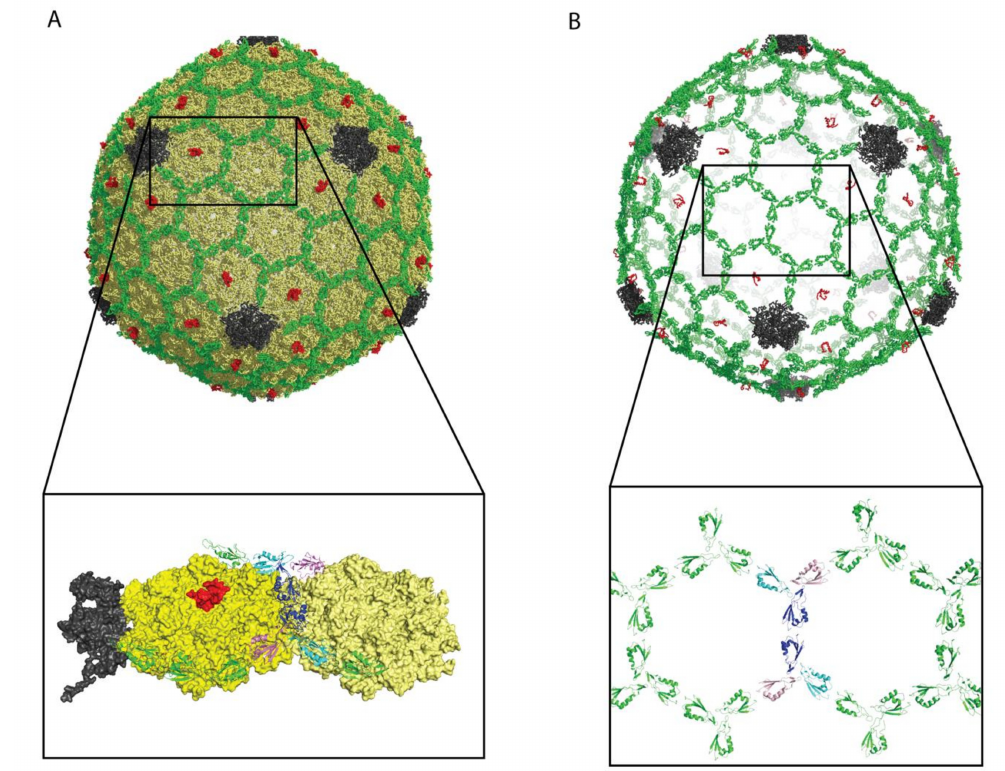
Figure 3. Structure of isometric T4 heads bound by Soc (T4) and Hoc (T4). The data are from PDB file 5VF3 [28]. ( A ) View of the complex: coat protein—yellow, vertex protein—grey, Soc (T4)—green, Hoc (T4)—red. Please note that only a small part of the HocT4 protein was visible in the 3.3 Å cryo-EM data. ( B ) View of the structure showing only Soc (T4) and Hoc (T4). The Soc (T4) decoration protein forms a chainmail-like structure surrounding the capsid. This is not the case for every decoration protein, for example the Dec (L) trimers in Figure 1B are isolated from each other. The expansion in ( B ) shows the Soc (T4) molecules surrounding two of the T4 hexons. For clarity two of the Soc (T4) trimers at the center of the hexons have their three protomers colored in blue, cyan, and